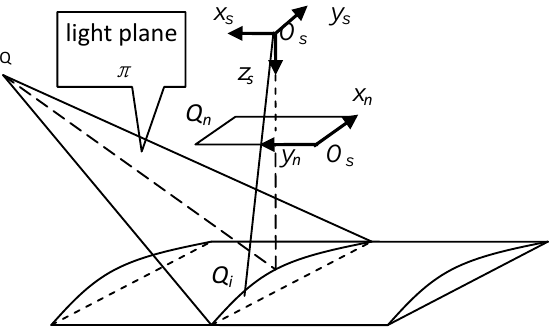
Figure 3. Mathematical model of line structure-line